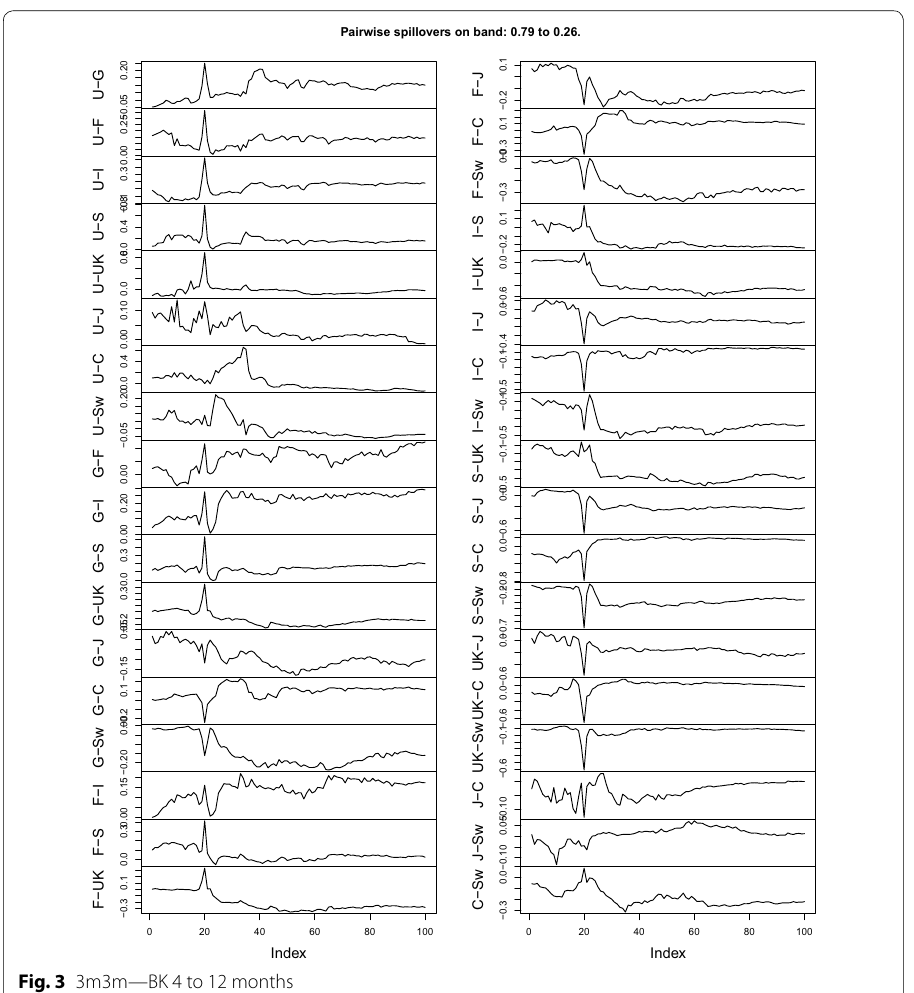
Fig. 3 3m3m—BK 4 to 12